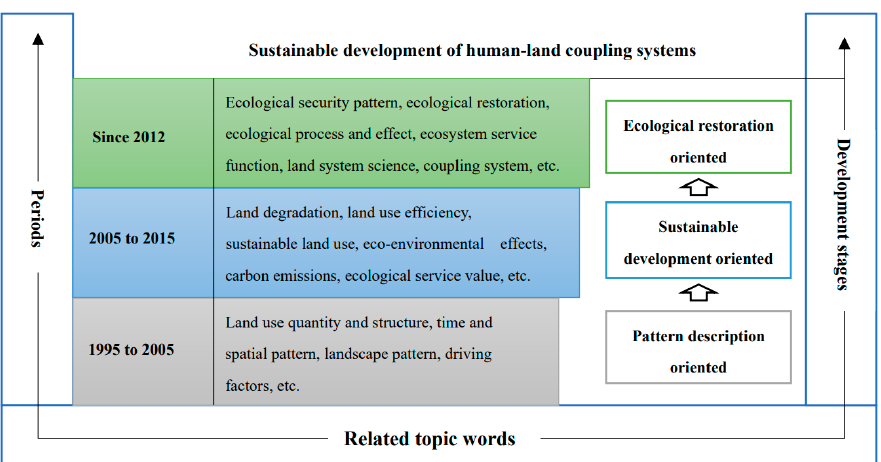
Figure 8. Stages and themes of spatial pattern of land use research.